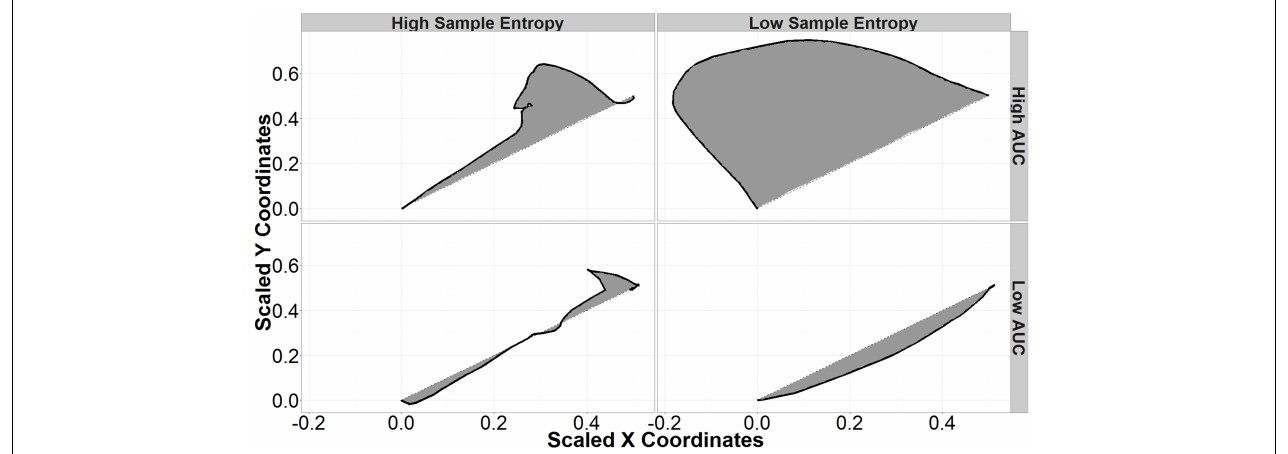
FIGURE 2 | Sample entropy (SE) and area under the curve (AUC) of sample mouse trajectories. The black lines represent Mouse trajectories and shaded areas represent the AUC. Trajectories with high SE (left column) are more variable; low SE trajectories are smooth curves (right column). High AUC trajectories (top row) deviate further from a hypothetical straight-line trajectory than those with low AUC (bottom